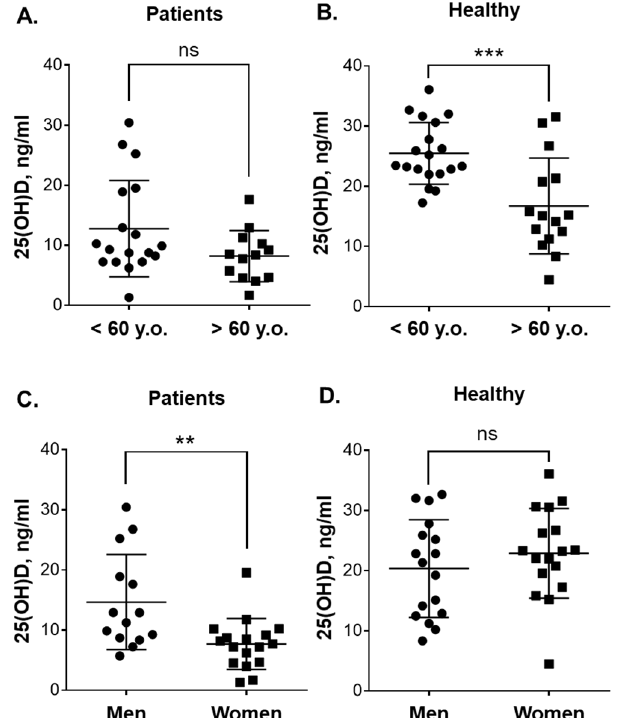
Figure 2. Plasma 25(OH)D levels in blood samples of patients with leukemia and healthy subjects of different age and gender. Comparison between: ( A ) younger ( n = 18) and older ( n = 13) patients; ( B ) younger ( n = 19) and older ( n = 15) healthy subjects, ( C ) male ( n = 14) and female ( n = 17) patients; and ( D ) male ( n = 17) and female ( n = 17) healthy subjects. Data are the means (long horizontal lines) ± SD. **, p < 0.01; ***, p < 0.001; ns, not significant; y.o., years old.